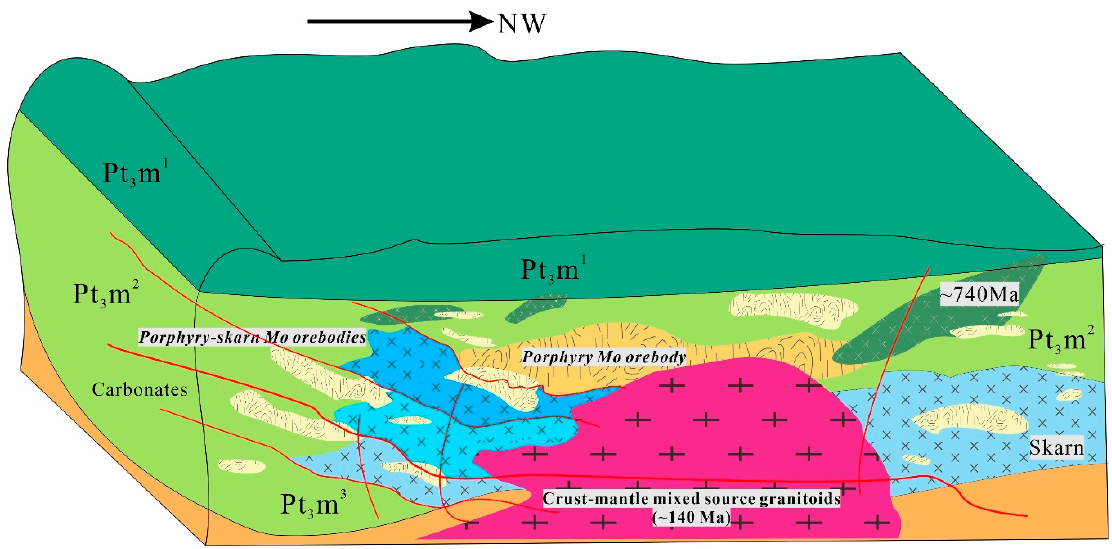
Figure 13. Sketch map of the Shangfanggou deposit exploration model.